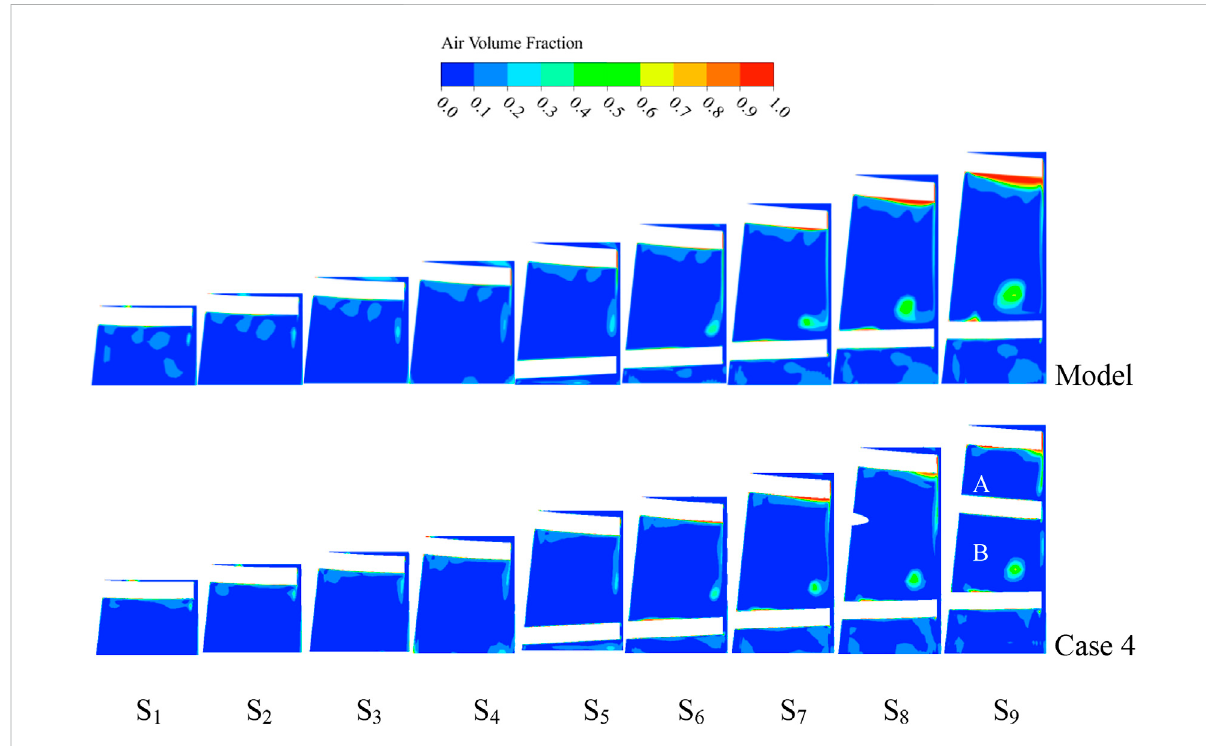
FIGURE 13 Gas distribution on S 1 ~ S 9 of the F region before and after complex